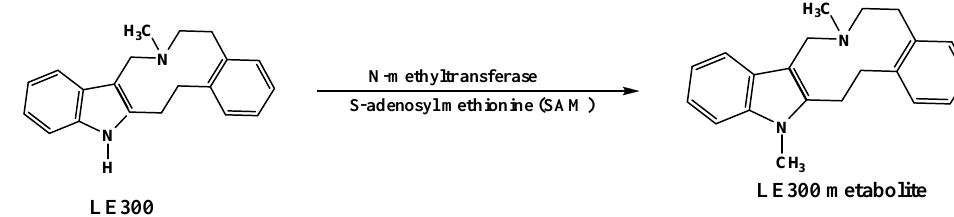
Figure 2. Metabolism pathway of LE300.